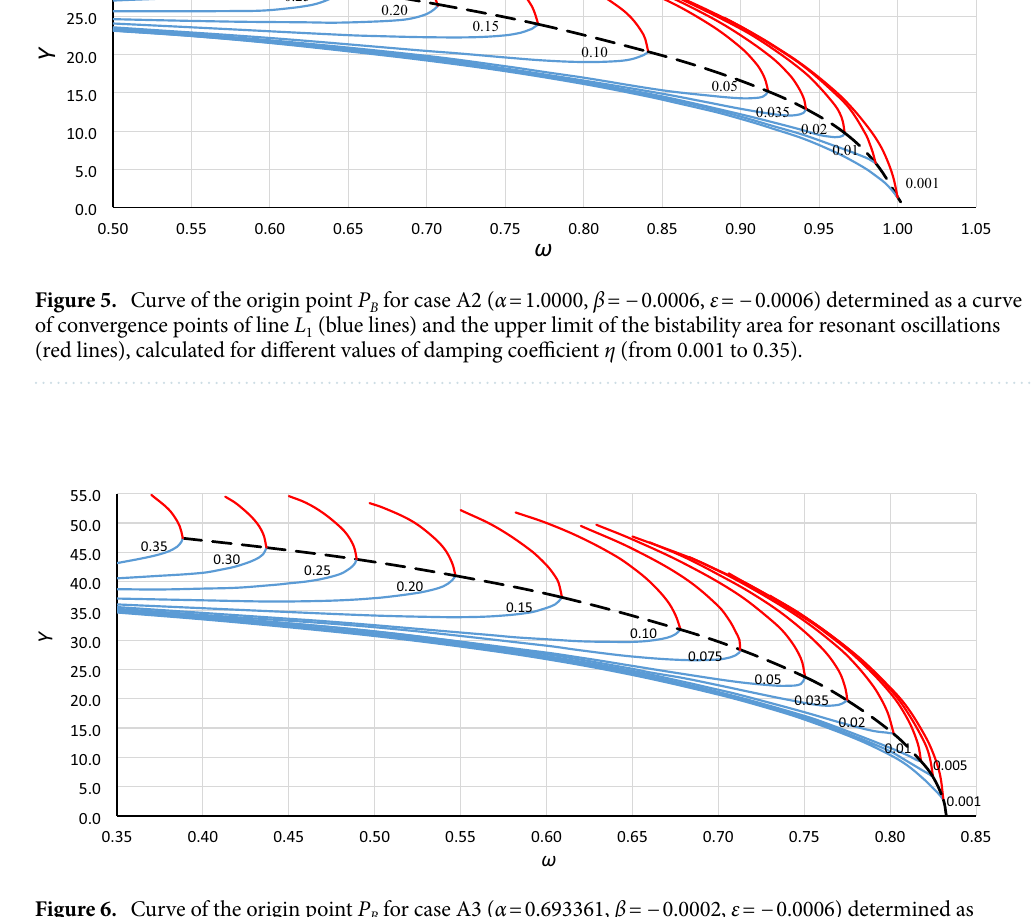
Figure 6. Curve of the origin point P B for case A3 ( α = 0.693361, β = − 0.0002, ε = − 0.0006) determined as a curve of convergence points of line L 1 (blue lines) and the upper limit of the bistability area for resonant oscillations (red lines), calculated for different values of damping coefficient η (from 0.001 to 0.35).